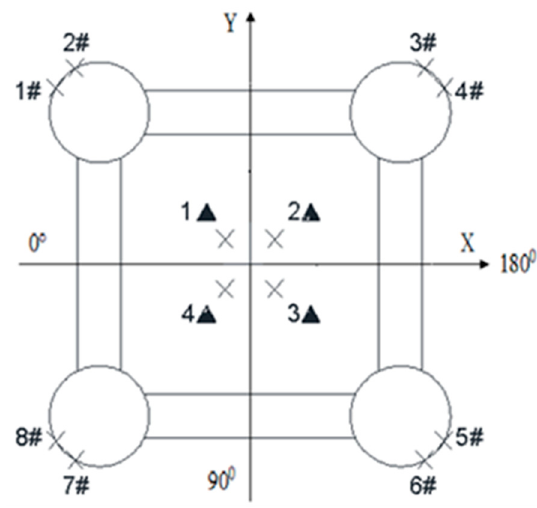
Figure 2. Test arrangement and coordinate system.